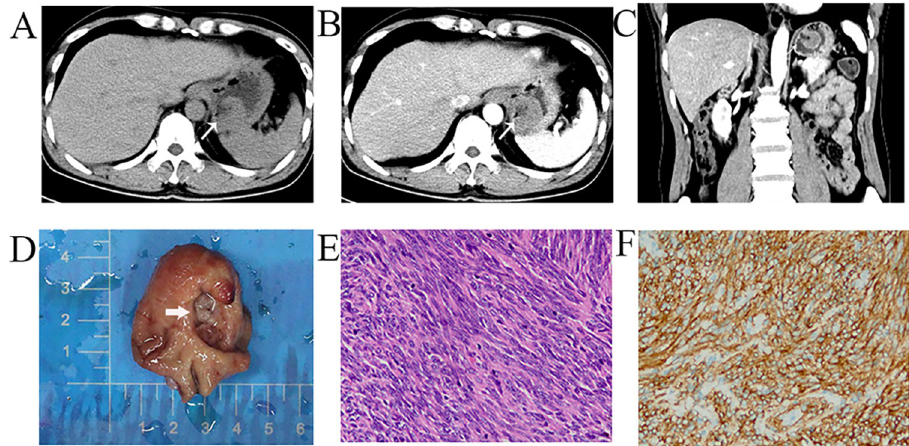
Fig 3. Representative CT images and histological examinations of GIST with an air-fluid level in the stomach. (A, B) Enhancement of tumor located in the fundus of the stomach) and air within the mass (white arrow, A & B); (C) The fistula between gastric cavity and tumor in CT reconstruction coronal position (white arrow) and (D) specimen (white arrowhead); (E) Histopathological result by H&E staining showed the spindle cells (magnification, x200); (F) Immunohistochemical staining (magnification, x200) showed positive for